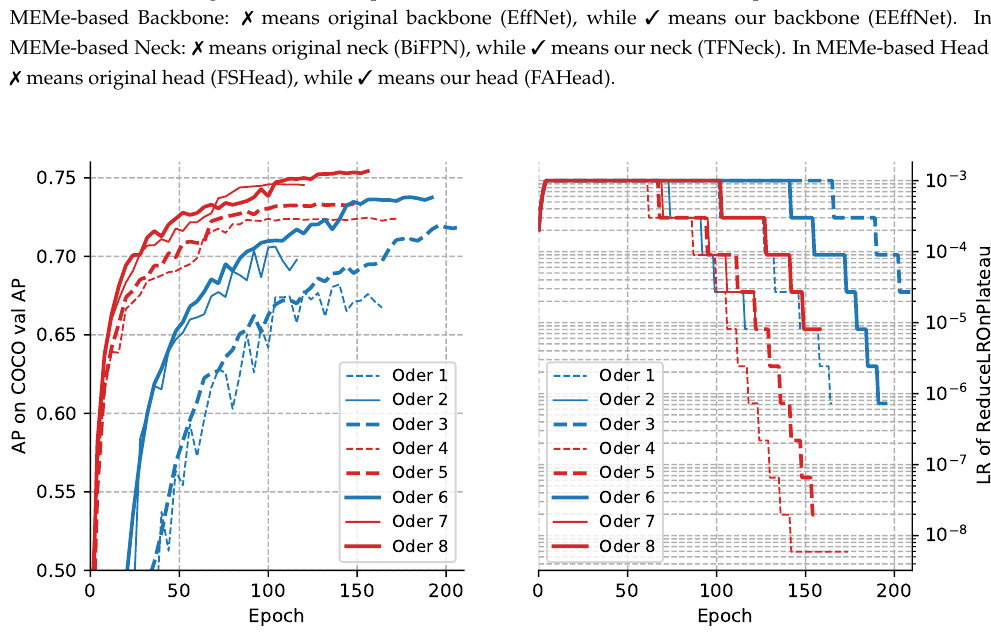
Figure 8. The convergence curves and LR self-adaption decay curves of ablation